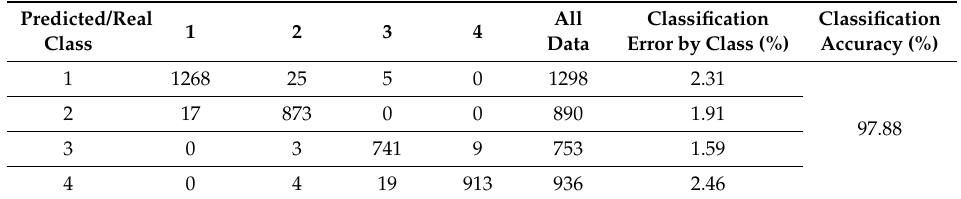
Table 6. Confusion matrix resulting from the classification of the ripening stage of the apples using the hybrid ANN-GA approach. Classes: 1. unripe; 2. half-ripe; 3. ripe; 4.